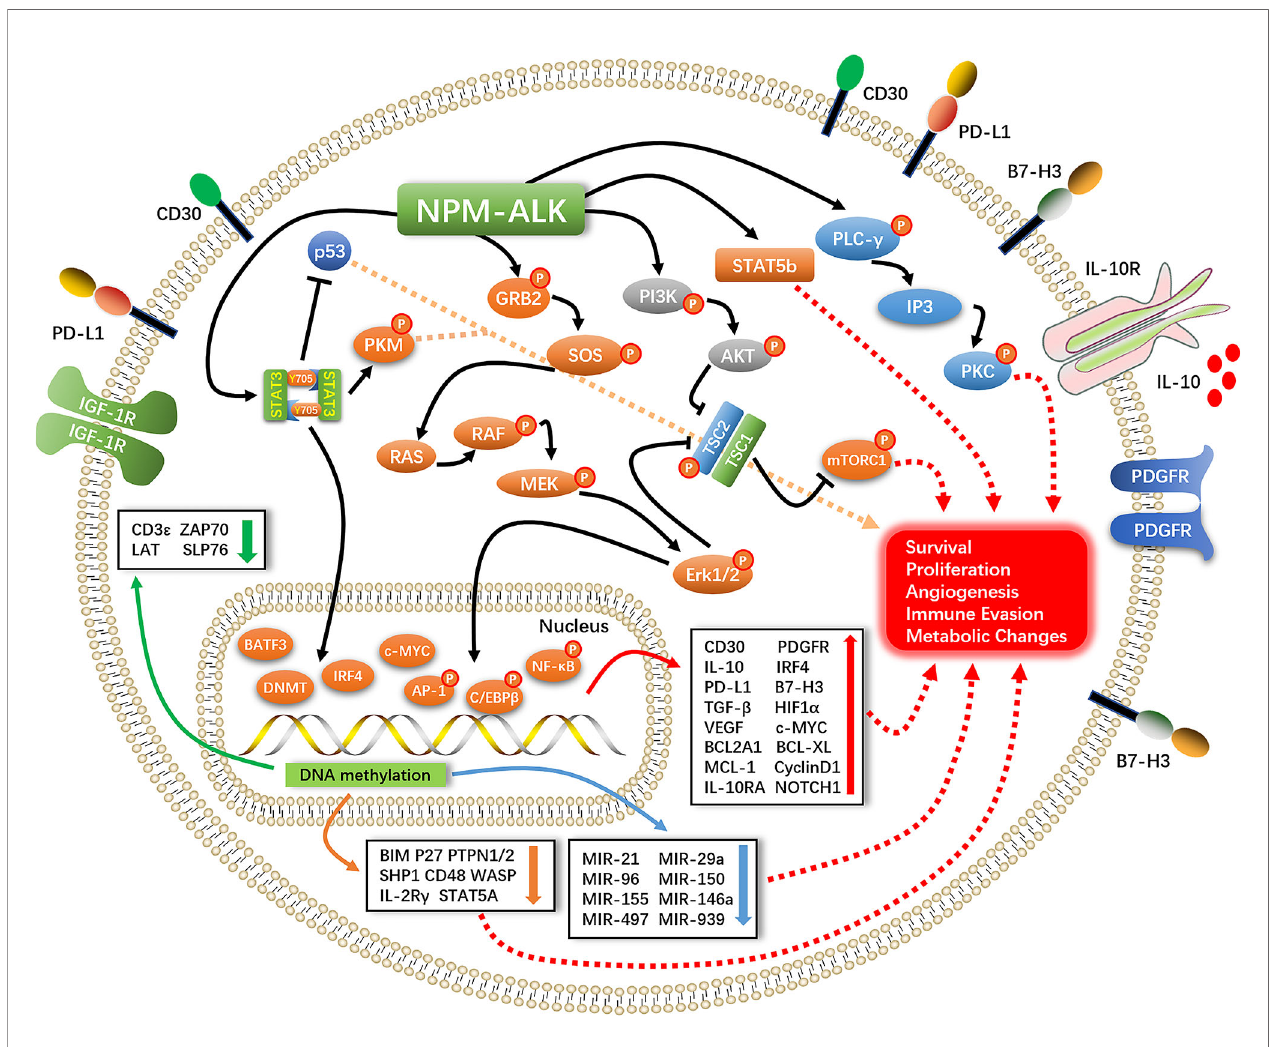
FIGURE 1 | Pathogenesis of